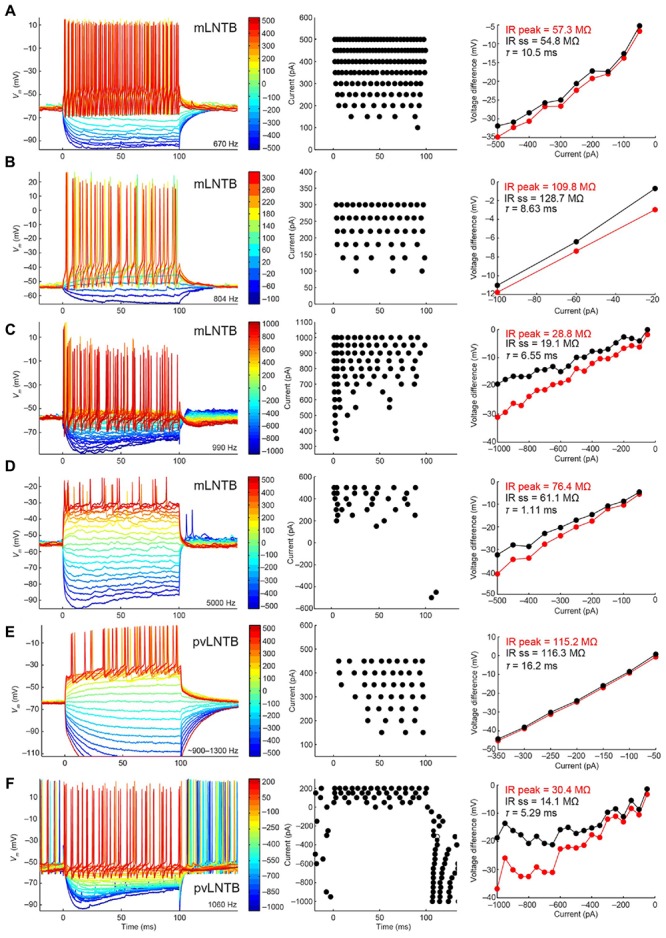
Voltage response to current steps for LNTB neurons. Voltage response to current injections is shown for six neurons: four mLNTB neurons (A–D) and two pvLNTB neurons (E,F). Left panels show voltage responses to hyperpolarizing and depolarizing current steps (color legend shows current amplitude in pA). Middle panels are dot rasters showing the action potentials from the left panels. Right panels are IV plots of the hyperpolarizing responses from the left panels, plotted separately for the peak and steady state response. The peak and steady state input resistance (IR) as well as the membrane time constant (τ) are mentioned in each panel. The bridge was sometimes not well-balanced, especially for the cell shown in (E). A post hoc calculation of the resistance showed that the true series resistance for this cell is about 108.6 MΩ (the bridge was balanced for 75.7 MΩ). The input resistance mentioned in (E) was corrected for this value.